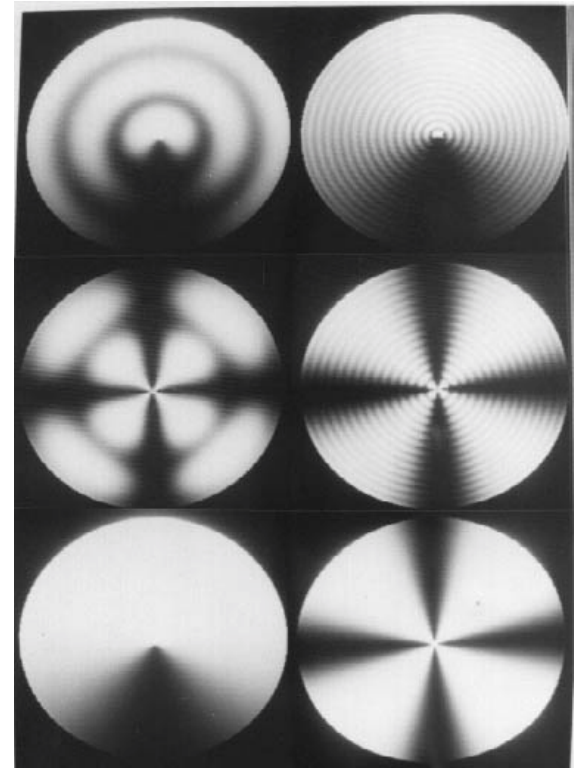
Figura 2. Exemplos de estímulos de freqüências radiais e angula- res acoplados. Acima à esquerda e à direita, as freqüências radiais de 0,5 cpg e 3 cpg acopladas à freqüência angular de 1 ciclo, respec- tivamente. No centro à direita e à esquerda as freqüências radiais 0,5 cpg e 3 cpg acopladas à freqüência angular de 4 ciclos. Embai- xo, as freqüências angulares de 1 e 4 ciclos, respectivamente. Estí- mulos originalmente calibrados para serem vistos a 150 cm de distância antes de